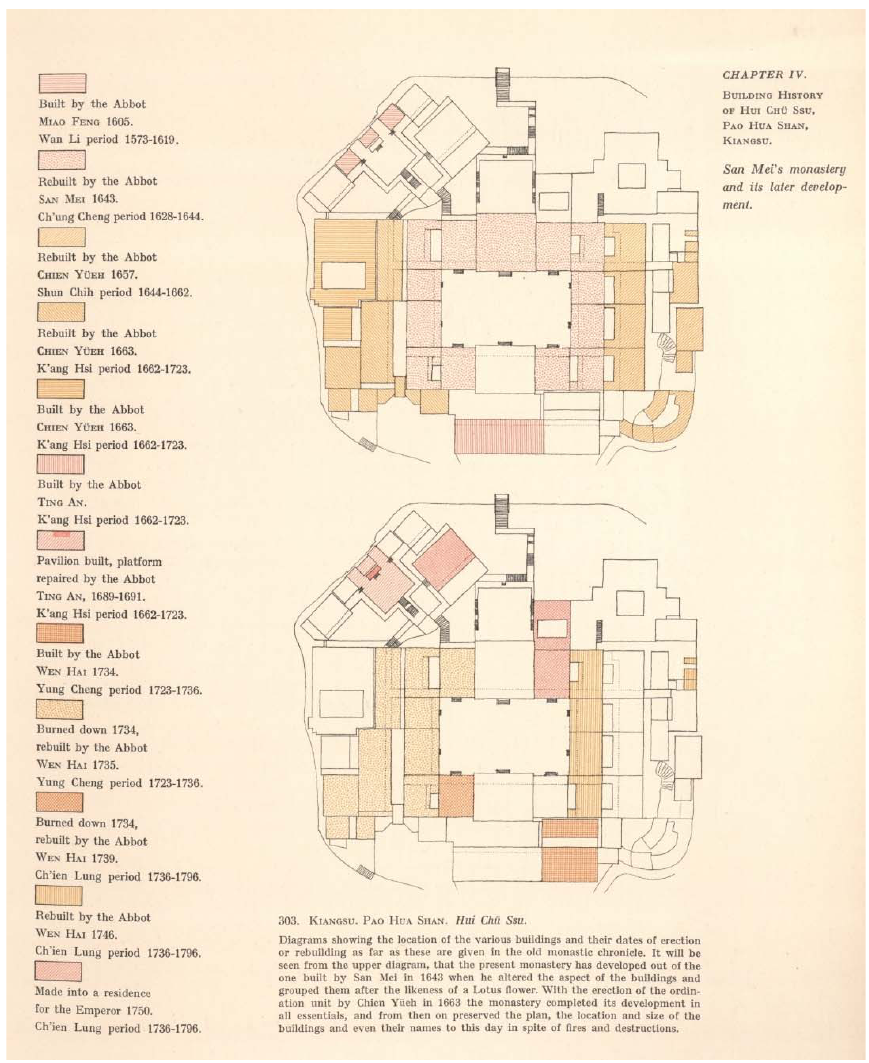
Figure 5. Building history of Longchang Monastery (Prip ‐ Møller 1937, p. 283, Figure 303).